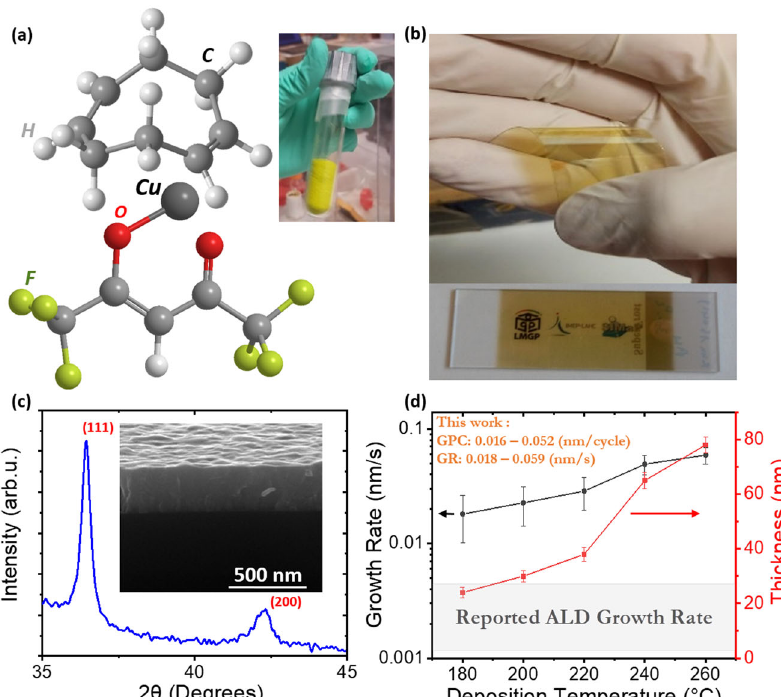
Fig. 1 Deposition of Cu 2 O thin fi lms using Cu(hfac)(cod). a 3D scheme and picture (top rigth) of the Cu(hfac)(cod) precursor used in this work. b Semitransparent Cu 2 O thin fi lms deposited on fl exible Neopulim ® (top) and borosilicate glass (bottom) substrates (7.5 cm × 2.5 cm). c XRD pattern and SEM cross-section (inset) of a 200-nm-thick Cu 2 O fi lm deposited on a borosilicate glass substrate at 220 °C for 8000 cycles (160 min). d Growth rate and thickness variation of Cu 2 O thin fi lms deposited on glass at different temperatures (1500 cycles in all cases) along with the growth rate of conventional ALD as reported in the literature. Error bars represent the min/max values obtained for each